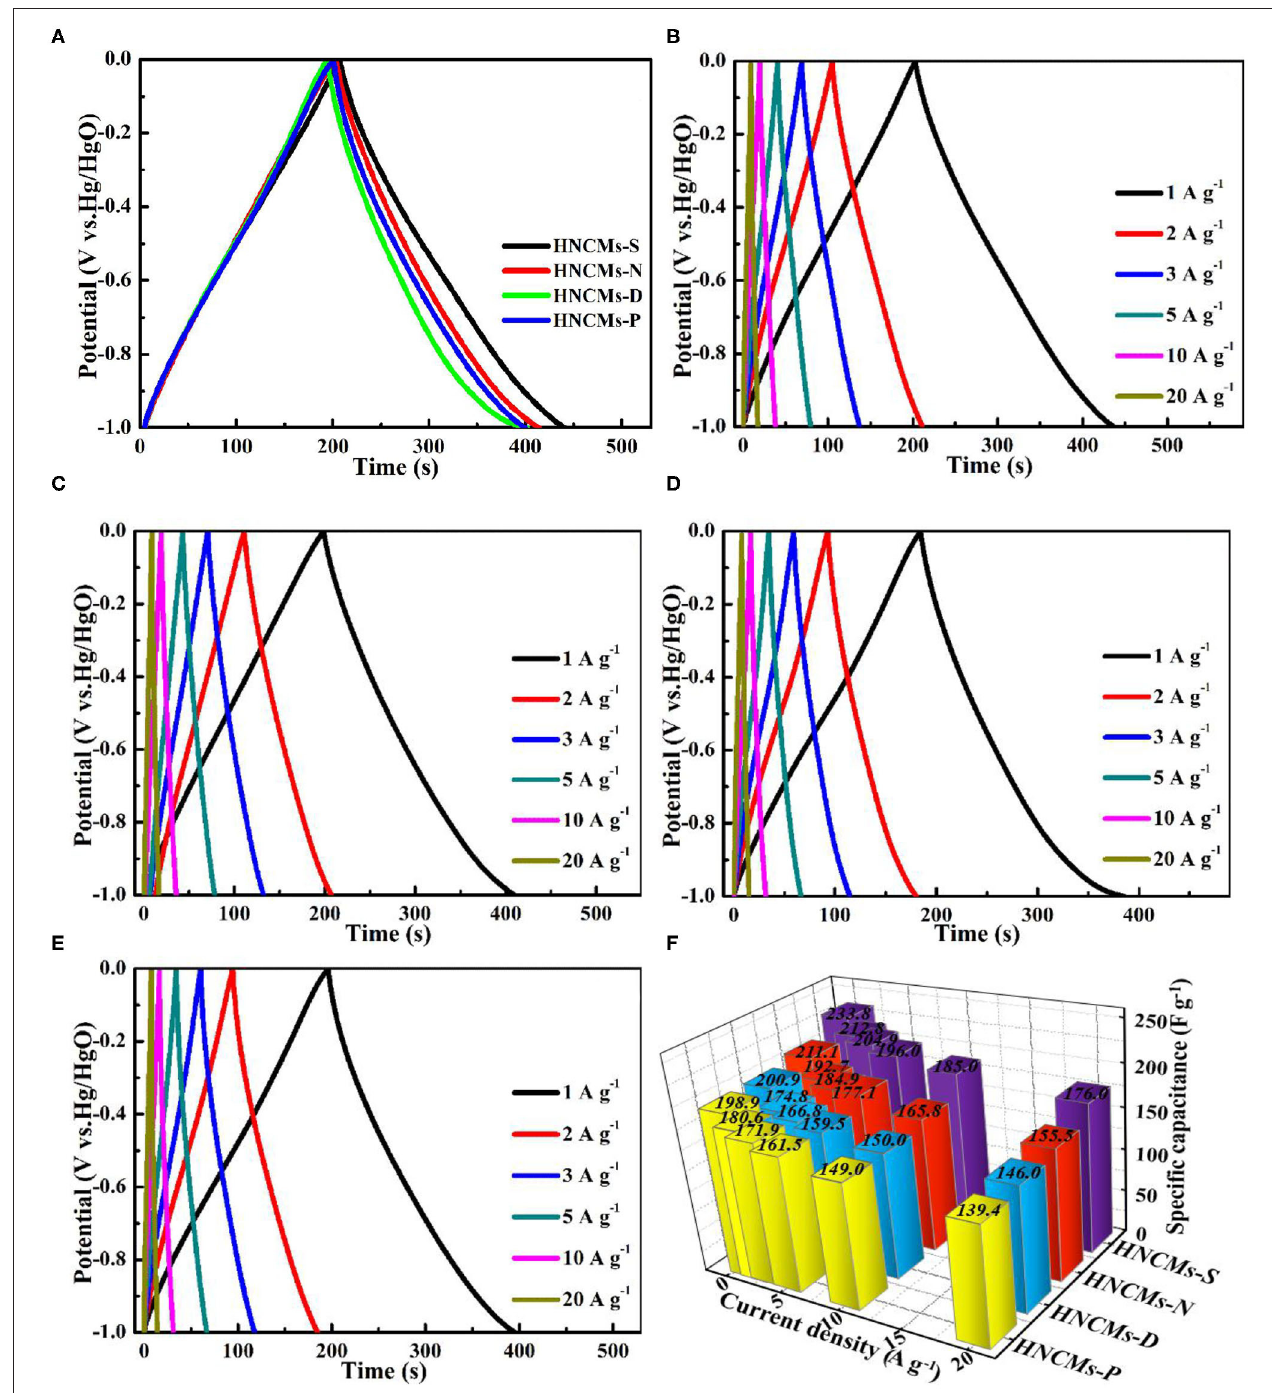
FIGURE 5 | (A) Constant current charge and discharge curves of different HNCM electrodes at current density of 1A g − 1 , constant current charge and discharge curves of HNCM samples at different current densities: (B) HNCMs-S, (C) HNCMs-N, (D) HNCMs-D and (E) HNCMs-P. (F) Specific capacitance of the HNCM electrodes as working electrodes at different current